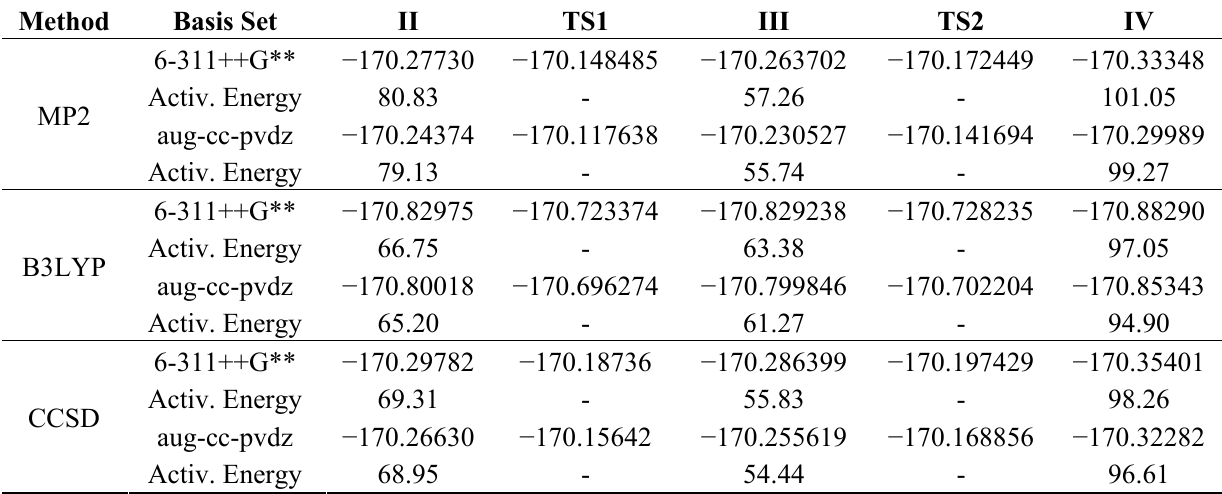
Table 6. Zero-point electronic energies (a.u.) and activation energies (kcal/mol) of the tautomerization of Z-prop-2-ynylidineamine (HC≡CCH=NH) (II) to form vinyl cyanide (CH =CHC≡N) (IV) through the Transition State 1 (TS1), (prop-1,2-diene-1-imine, 2 CH =C=C=NH) (III) and Transition State 2 (TS2). 2